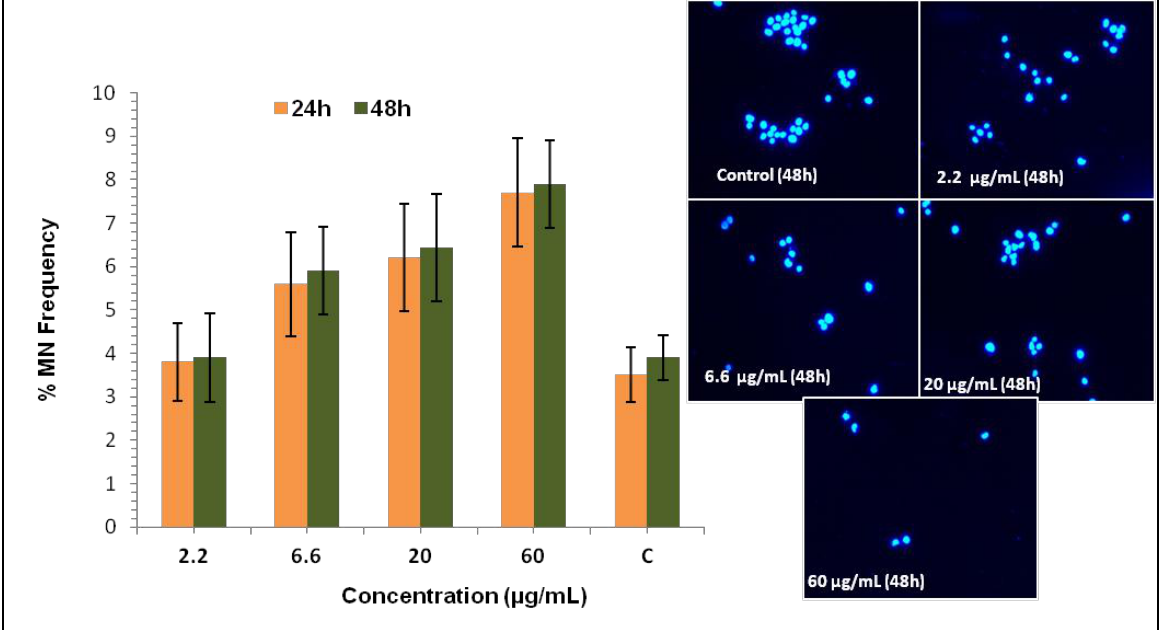
Figure 6. Comparison between micronucleus (MN) frequencies at 24 and 48 h in human T98G cells treated with compound 2 . Whereas ‘Control’ is micronuclei frequency of untreated cells.Results are measured in vitro both in mononucleated cells and binucleated cells in cultures. These cells shown with one or many micronucleus were scored for MN frequency. The data represents mean ± SEM, n =